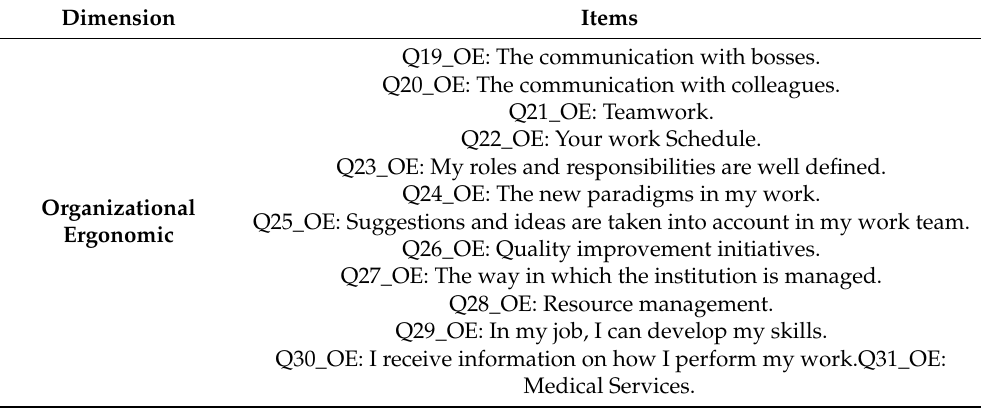
Table 9. Constructs of organizational ergonomics. Dimension